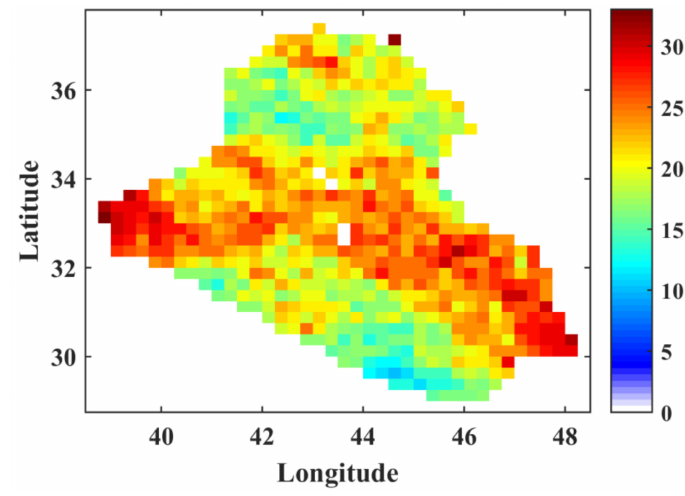
Figure 6. Drought frequency across Iraq for the period of 1948–2009 based on